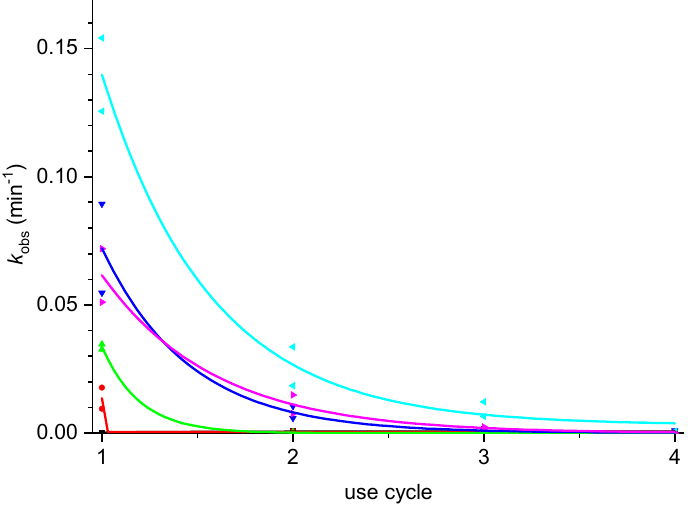
Figure 8. Observed first ‐ order rate constants k obs as a function of use cycle of the catalyst Pd ‐ PPy ‐ PS at initial catalyst Pd concentrations of 1.8 μ M for the homocoupling reaction of 150 μ M 1 in pH 9 borate buffer (10 mM) over the course of 21 h at 70 °C in the presence of 4.45 M (black), 4 M (red), 2 M (green), 1 M (blue), 0.5 M (cyan), and 0 M (magenta) bromide. Lines are fits of a first ‐ order kinetic model to the data.